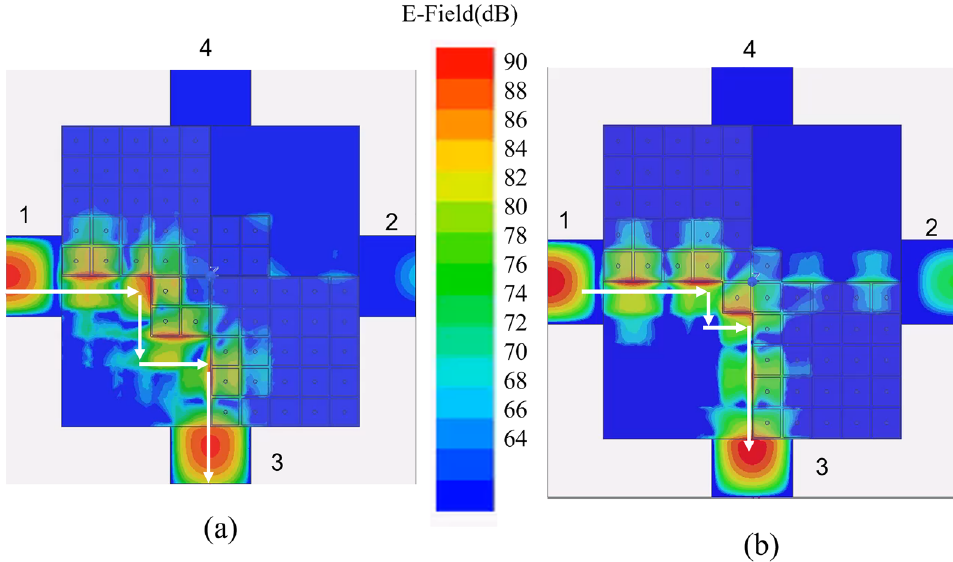
Figure 7. Amplitude of the electric field at 29.8 GHz simulated with Ansys HFSS 2020 30 , ( a ): 4x4 unit celles in the central region (design of Fig. 5); ( b ): 2X2 cells in the central region (design of Fig. 6b).